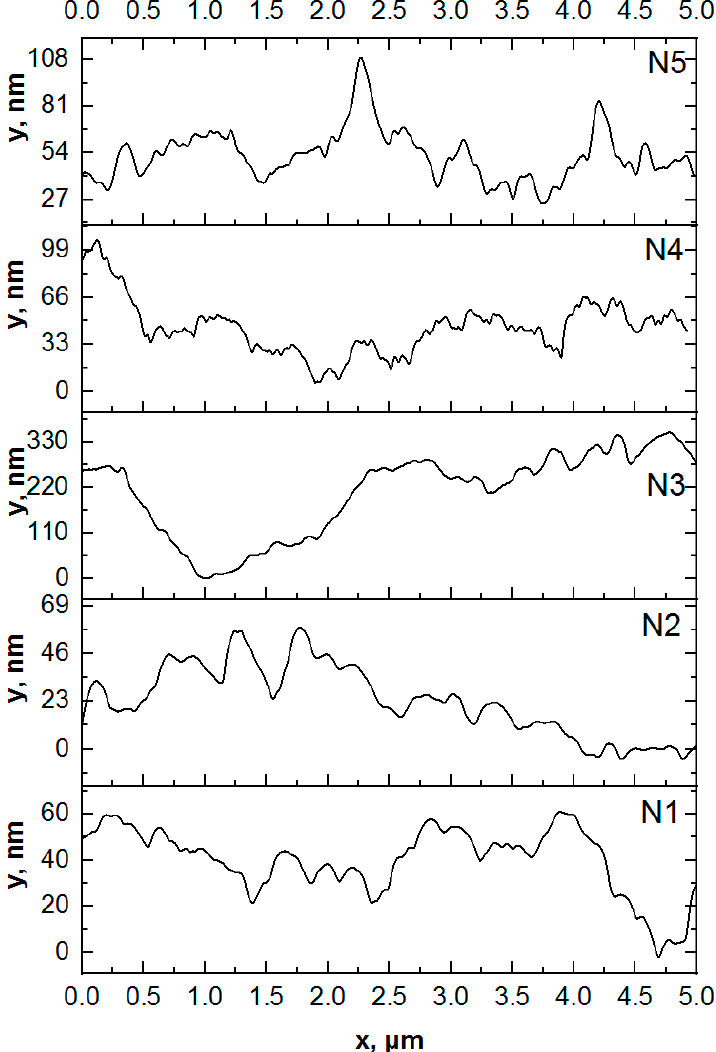
Figure 4. Line-cut profiles of AFM topography images: sample N1: healthy tooth enamel without treatment; sample N2: without pretreatment and with subsequent mineralization; sample N3: after surface pretreatment with H 3 PO 4 and subsequent mineralization; sample N4: after surface pretreatment with Ca(OH) 2 and subsequent mineralization; sample N5: after surface pretreatment with Ca(OH) 2 and an amino acid booster, with subsequent mineralization.